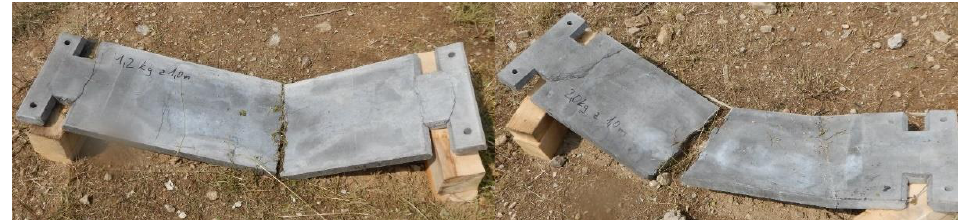
Figure 18. Global failure (GF) of the UHPFRCC slab due to the explosion of 1.2 kg of TNT from a stand-off distance of 1 m (on the left) and global failure (GF) of the UHPFRCC slab from the blast experiment of 2 kg of TNT from 1 m (on the right).